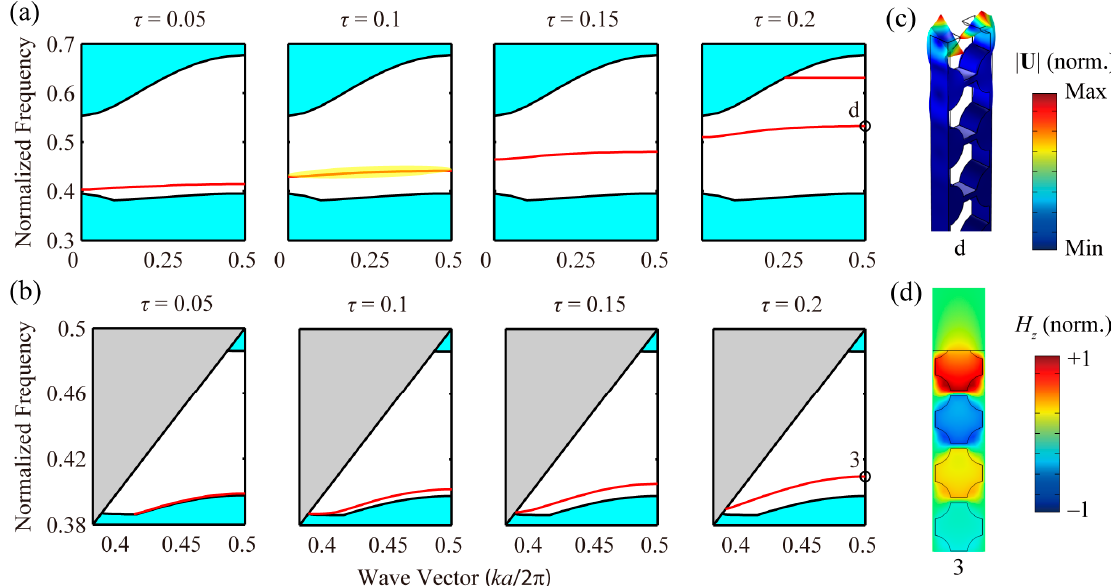
Figure 5. Dispersion curves of the surface wave bands of phononic ( a ) and photonic even ( b ) modes for different τ , where τ increases from 0.05 to 0.2 with a step of 0.05. The cyan and gray areas represent the projected bulk modes and light cone, respectively. ( c ) Displacement field distributions and deformed patterns corresponding to different phononic surface bands. ( d ) Magnetic field ( H Z ) distributions at plane z = 0, corresponding to different photonic surface bands.